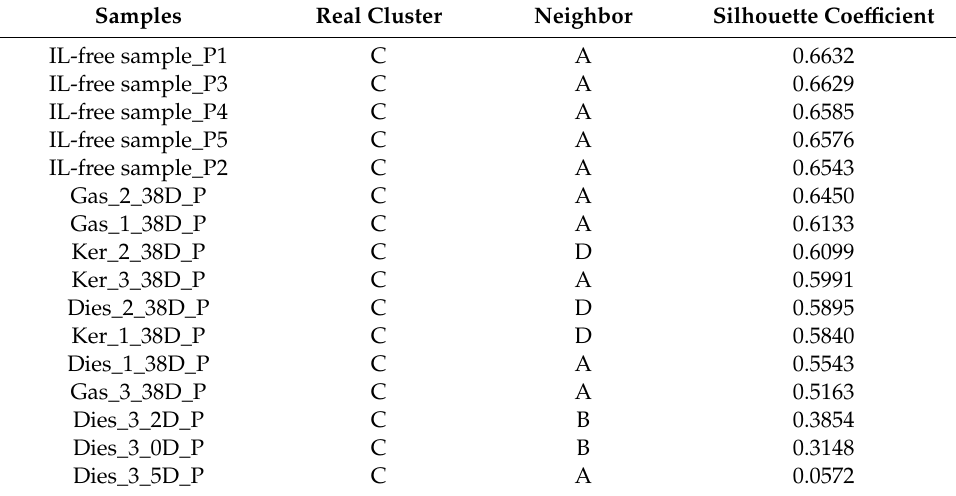
Table 3. Silhouette coe ffi cients for cluster